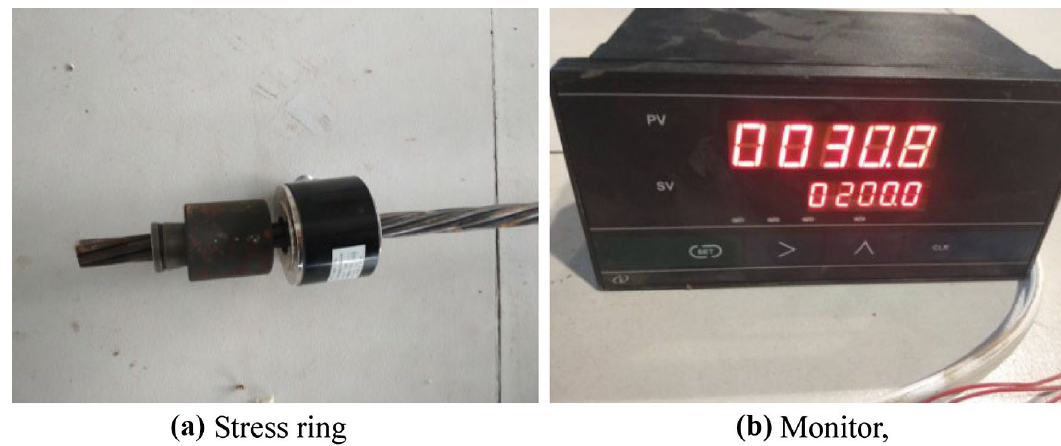
Fig. 22 Prestress measuring